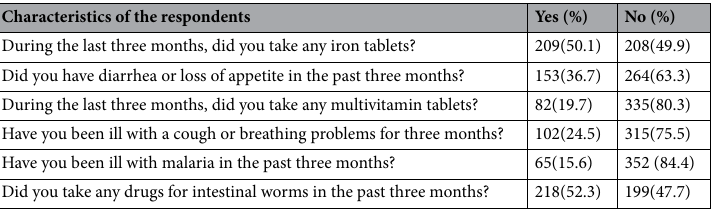
Table 2. Clinical results among pregnant women attending antenatal care in Kellem Wellega zone, Western Ethiopia.